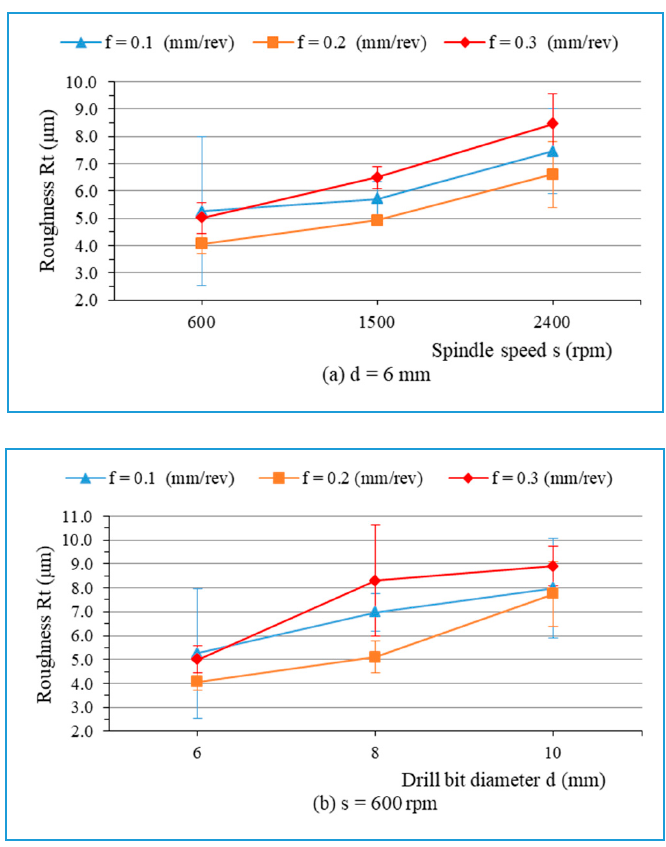
Figure 14. Roughness R t versus the cutting conditions: ( a ) d = 6 mm; and ( b ) s = 600 rpm.